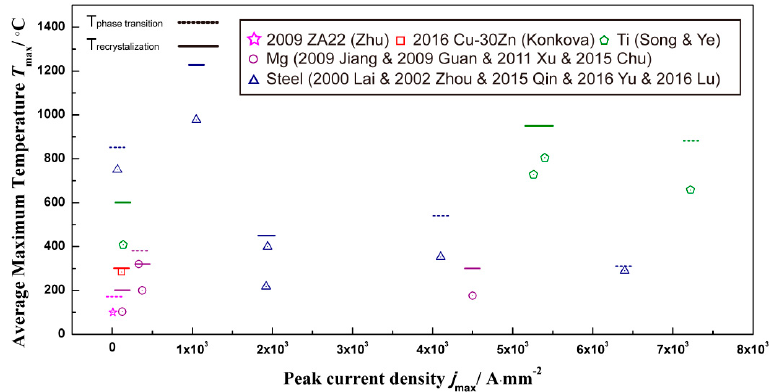
Figure 12. The average maximum temperature of different metals and alloys with different peak current densities [24,30,52,53,59,63,67,78,82,85,98,101,112,114,123,125,131].